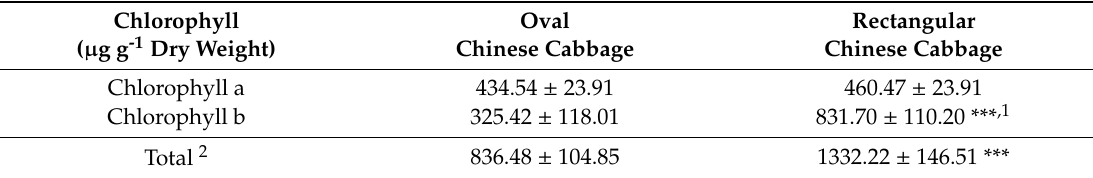
Table 4. Chlorophyll contents in oval and rectangular Chinese